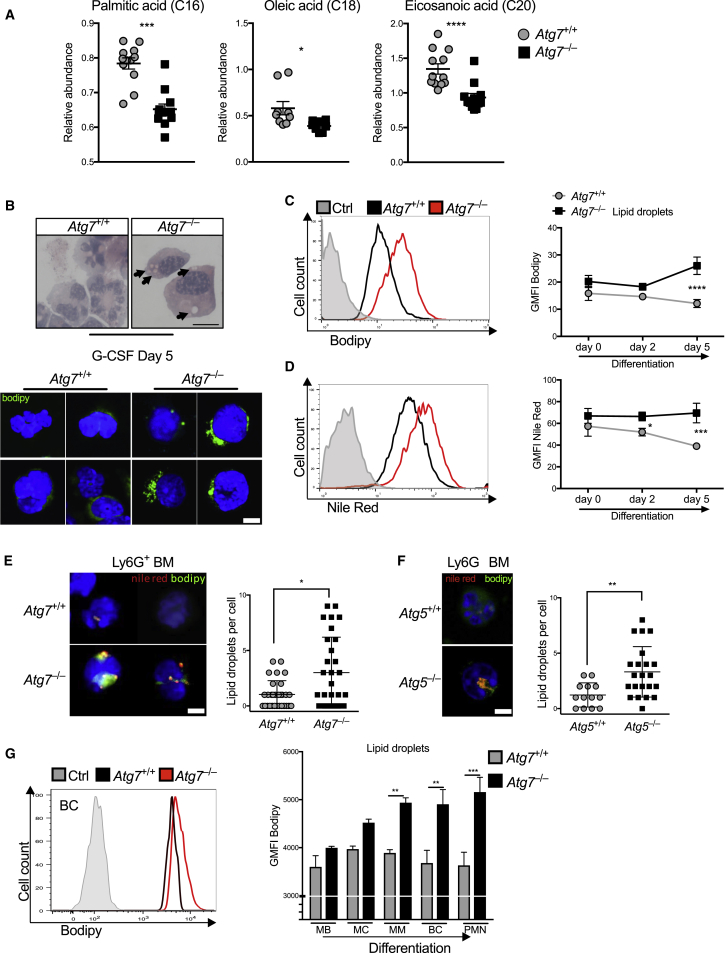
Autophagy Mediates Lipolysis during Neutrophil Differentiation(A) Free fatty acid abundance in Atg7+/+ and CRISPR-Atg7–/– clones quantified by GCxGC/MS. Data represent 5–6 biological replicates per genotype from two independent clones. ∗p < 0.05, ∗∗∗p < 0.001, ∗∗∗∗p < 0.0001.(B) Wright-Giemsa-stained cytospins (top) and confocal micropgraphs (bottom) from two independent experiments showing lipid droplets stained with Bodipy 493/503 (1 ng/mL) in Atg7+/+ and CRISPR-Atg7–/– clones after culture in G-CSF (100 nM) for 5 days; arrows indicate lipid droplets. Scale bar, 5 μm.(C and D) Representative histograms (left) and geometric MFI (right) from two experiments showing (C) Bodipy and (D) Nile red lipid-droplet dye in Atg7+/+ and Atg7–/– myeloblasts after the indicated duration of G-CSF (100 nM)-induced differentiation. Histograms are from day 5, gray is unstained control from day 0. ∗p < 0.05, ∗∗∗p < 0.001, ∗∗∗∗p < 0.0001, tested by two-way ANOVA.(E and F) Nile red+ Bodipy+ lipid droplets were quantified by confocal microscopy in isolated total Ly6G+ BM cells from (E) Atg7+/+ and Atg7–/– mice or (F) Atg5+/+ and Atg5–/– mice (Cebpa-cre+ × Atg5f/f). Confocal micrographs (left; scale bar, 5 μm) and quantification as lipid droplets/cell ± SEM (right). Data in (E) are combined from two independent experiments (n = 3 mice). ∗p < 0.05, ∗∗p < 0.01.(G) Representative histograms of Bodipy fluorescence in Atg7+/+ and Cebpa-cre+ × Atg7f/f (Atg7–/–) precursors (left) and quantification of lipid droplets as the geometric MFI ± SEM from the indicated Atg7+/+ and Atg7–/– BM precursor populations (n = 3 mice), representative of three independent experiments. ∗∗p < 0.01, ∗∗∗p < 0.001, tested by two-way ANOVA.See also Figure S5.